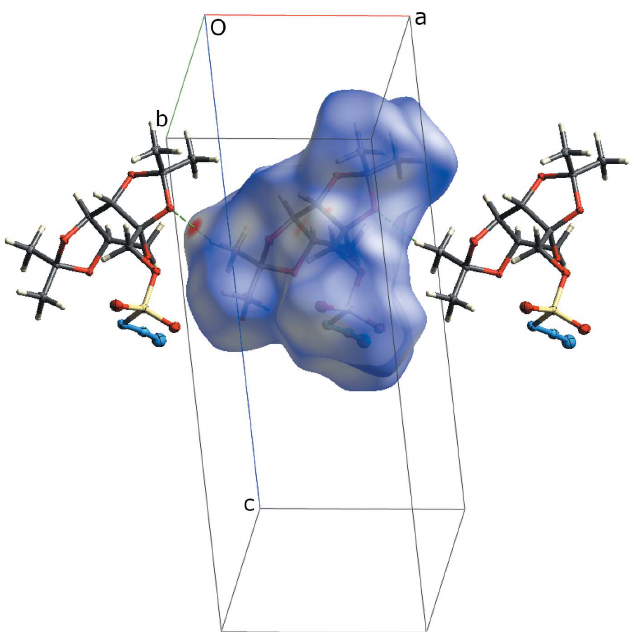
Figure 3 A plot of the Hirshfeld surface calculated over d norm for I at 90 K, showing two adjacent molecules. Hydrogen bonds are drawn as green dashed lines. The red spot at the left corresponds to the C7—H7 A (cid:2)(cid:2)(cid:2) O5 i [symmetry code: (i) x (cid:3) 1, y , z ] hydrogen bond (Table 3). The symmetry- equivalent red spot on the right side of the Hirshfeld surface is obscured from